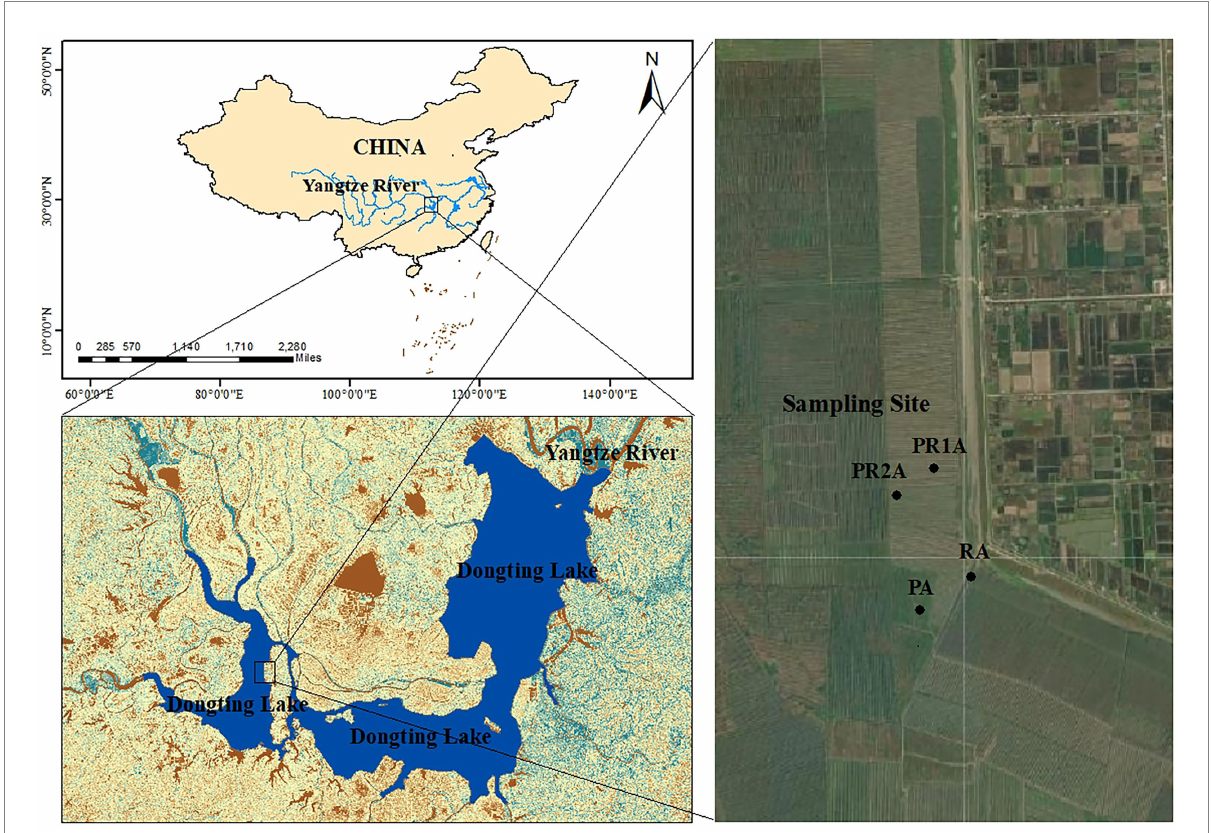
FIGURE 1 Locations of Dongting Lake and sample points of the reed area (RA), poplar planting area (PA), poplar retreat for 1-year area (PR1A) and poplar retreat for 2 years area